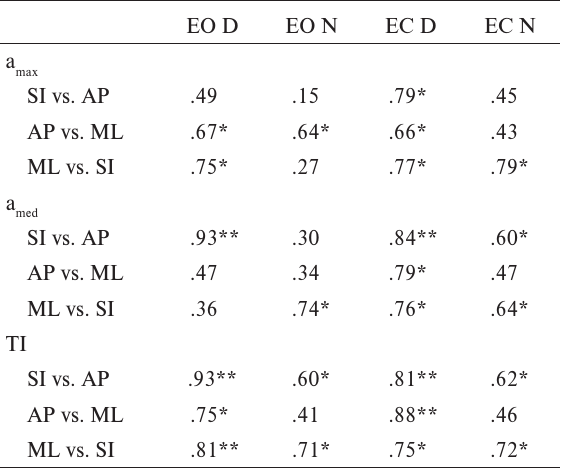
Table 3 Spearman’s rank correlation coefficients between the superior-inferior, medio-lateral and anterior-posterior